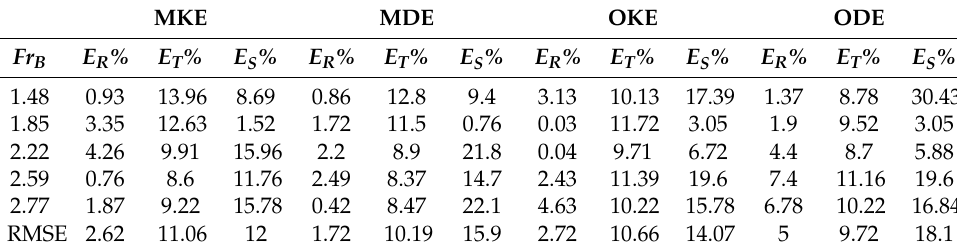
Table 5. Summary of the errors of different CFD models used in the current research. MKE MDE